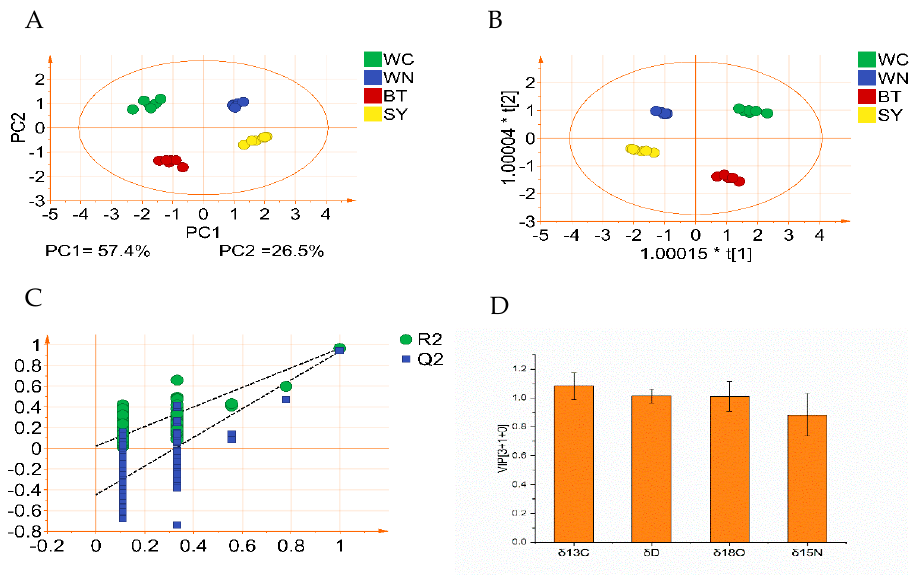
Figure 3. Principal component analysis (PCA) and orthogonal partial least squares discriminant analysis (OPLS-DA) results of stable isotope ratios of partridge tea from four origins (SY, WN, WC, and BT): ( A ) 2D scores plot of PCA; ( B ) 2D scores plot of OPLS-DA; ( C ) result map of 200 cross- validation of OPLS-DA model; ( D ) VIP map of contribution of each variable to sample